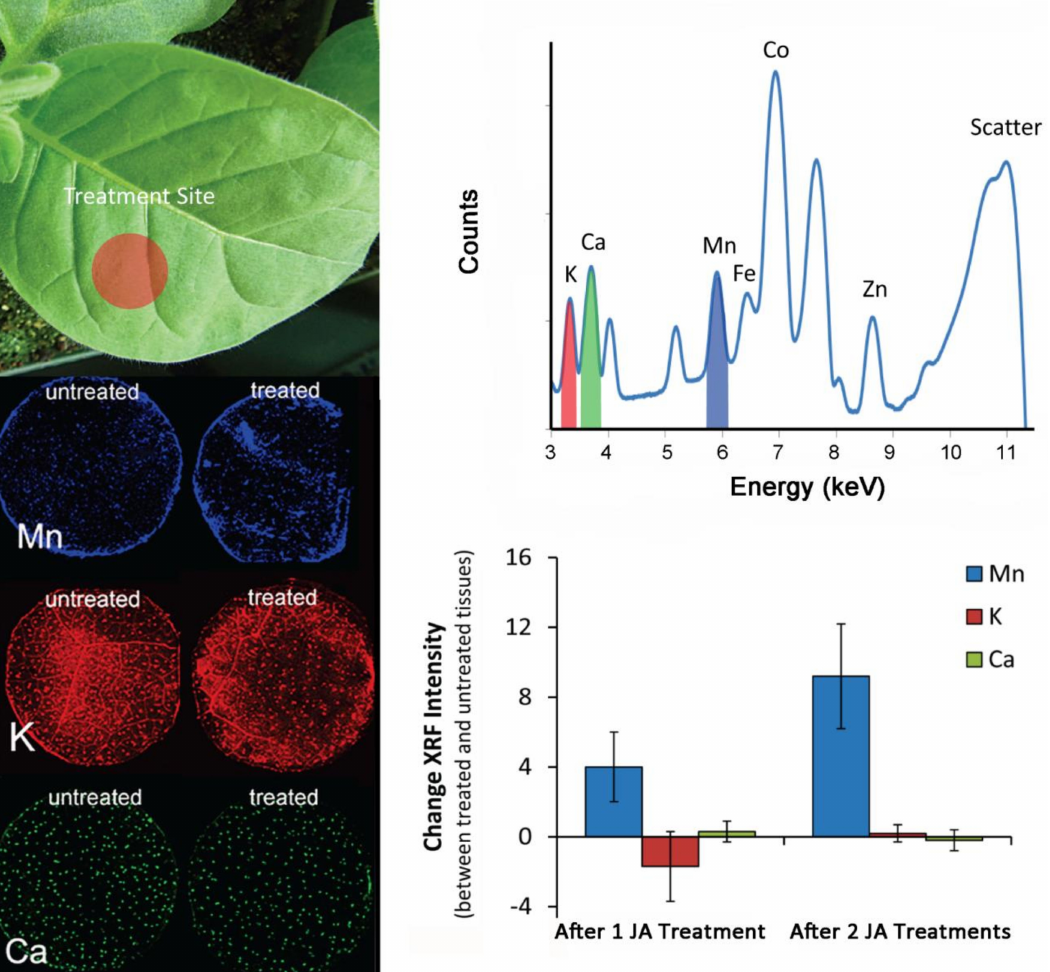
Figure 8. Synchrotron-based X-ray fluorescence imaging allows for spatial mapping of metals in leaf tissue based on their characteristic fluorescence signature after having absorbed the energy from a high-energy X-ray source. Metals will absorb X-rays and fluoresce at di ff erent energies characteristic of the element and its orbital makeup of electrons (upper right-side panel). This feature enables the distinction of di ff erent metals in the same sample (left panel). Images were acquired 15 h after each JA treatment and comparisons made between tissues taken from treated and non-treated halves of the same leaf-3. Data (N = 3) were presented as the fold-change ± SE relative to non-treated tissue levels (lower right-side